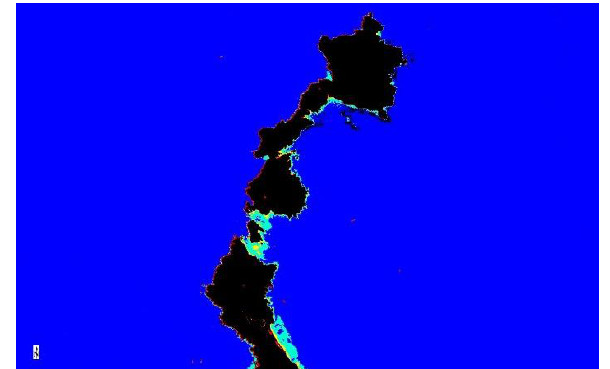
Figure 5. Results of the DOP zones calculation on the selected area.